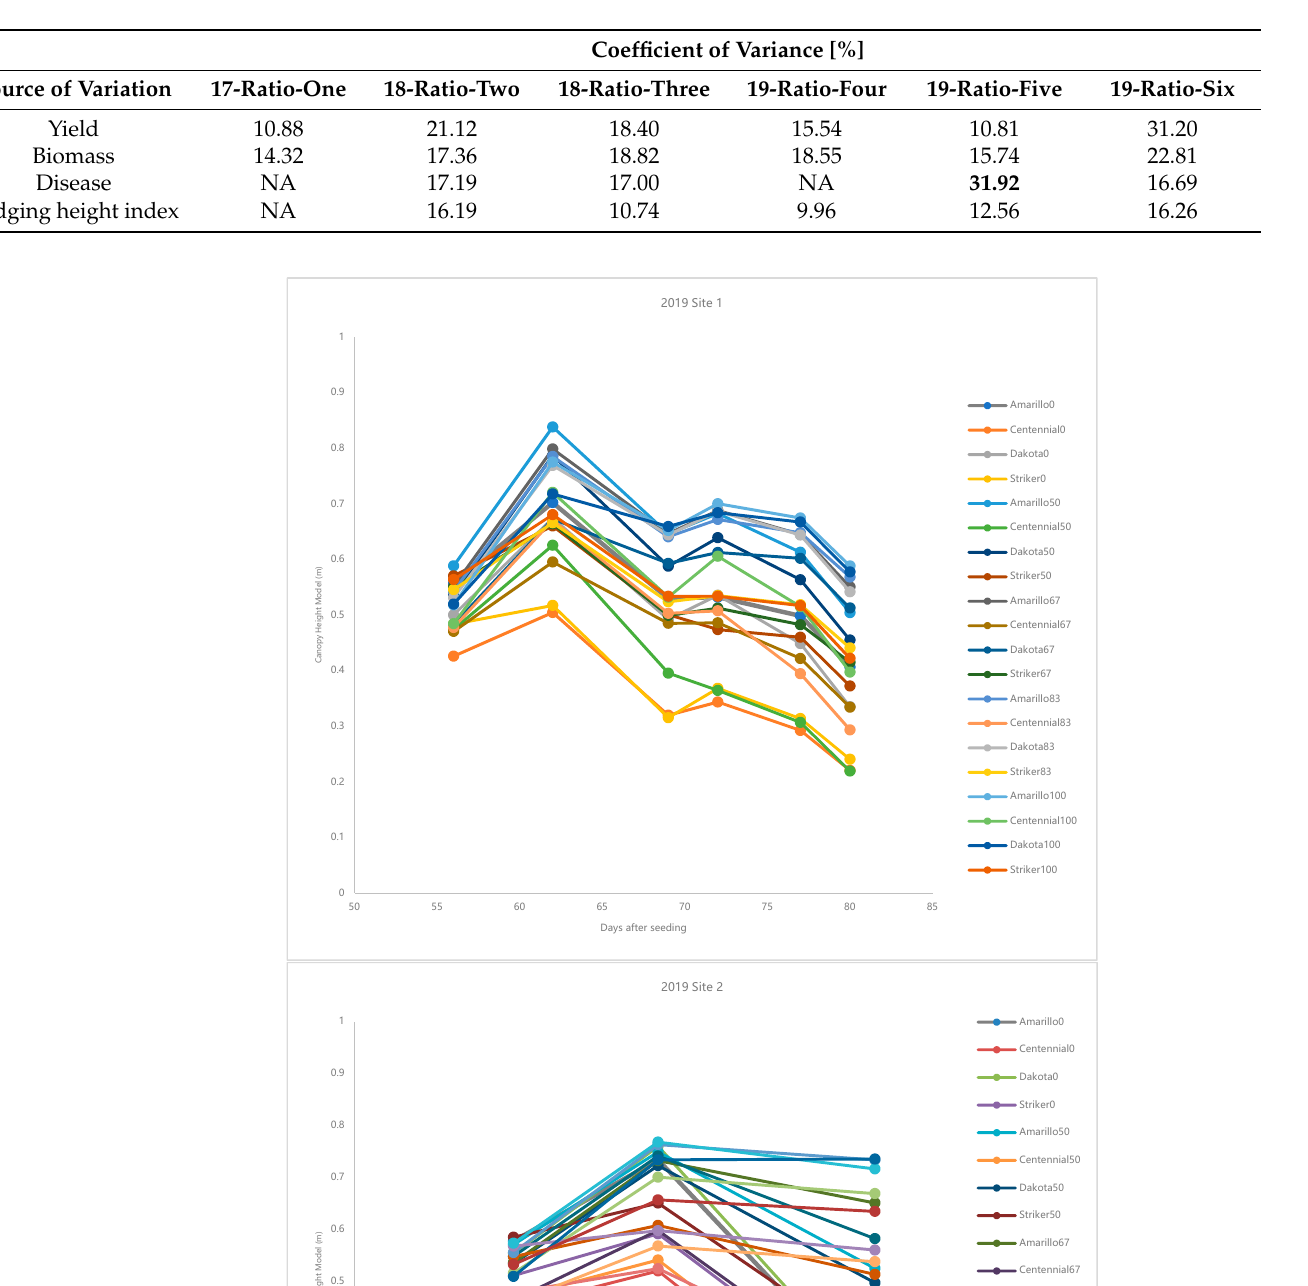
Table A3. Coefficient of Variance for the response variables at 6 site-year during 2017 & 2018 &2019 in central Saskatchewan.